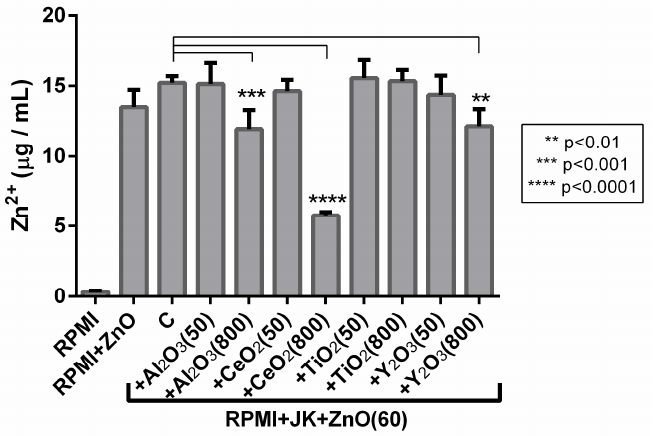
Figure 2. Concentration of dissolved Zn 2+ by ICP-OES. The concentration of Zn 2+ in a culture medium released by 60 µg/mL ZnO Nps is represented. In all cases the concentration of Zn 2+ is the same or higher when ZnO Nps are combined with metal oxide Nps at 50 µg/mL and lower when combined with metal oxide Nps at 800 µg/mL, except for TiO 2 Nps ( n = 2). C: control sample, ZnO Nps at 60 µg/mL in the presence of Jurkat cells incubated in RPMI. The metal oxide Np combinations were compared to this sample for the statistical analysis. Asterisks and lines highlight the statistically significant differences.